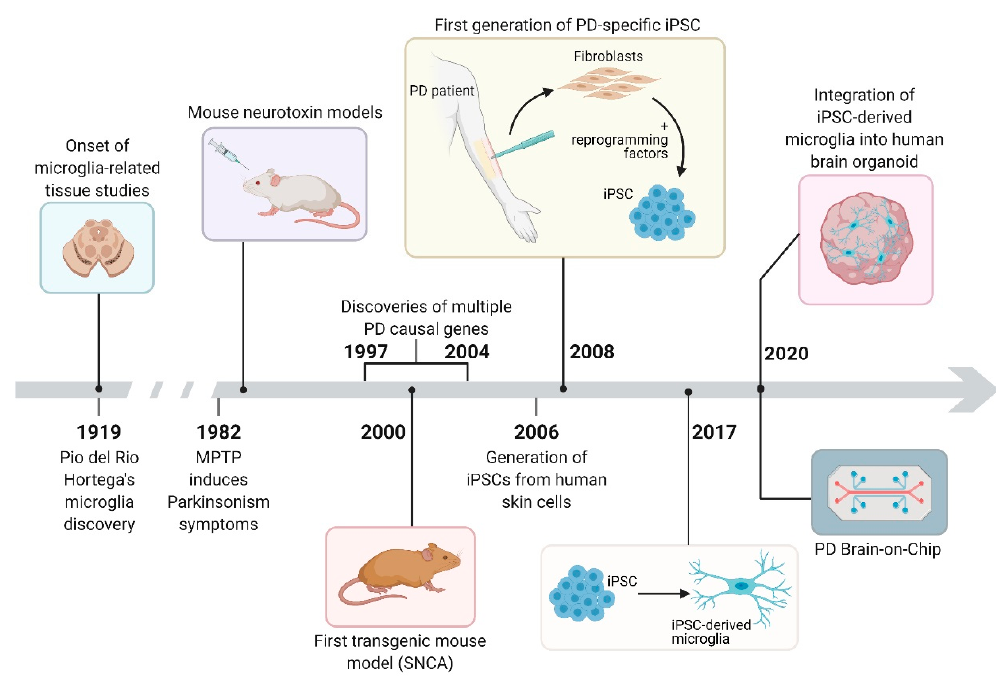
Figure 1. Historical overview of the different model systems used in PD microglia research. Figure created using BioRen- der.com.